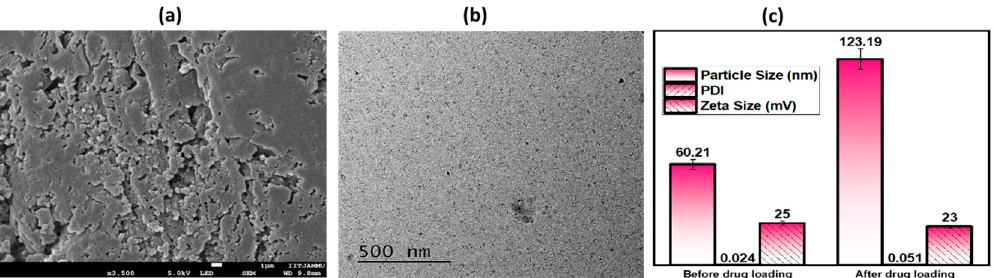
Figure 1. Physicochemical analysis: ( a ) FE-SEM image of gel prepared from FEO–PLGANPs; ( b ) TEM image of prepared gel; ( c ) measurements of particle size, polydispersity index and zeta potential of gel prepared from FEO–PLGANPs before and after drug loading.